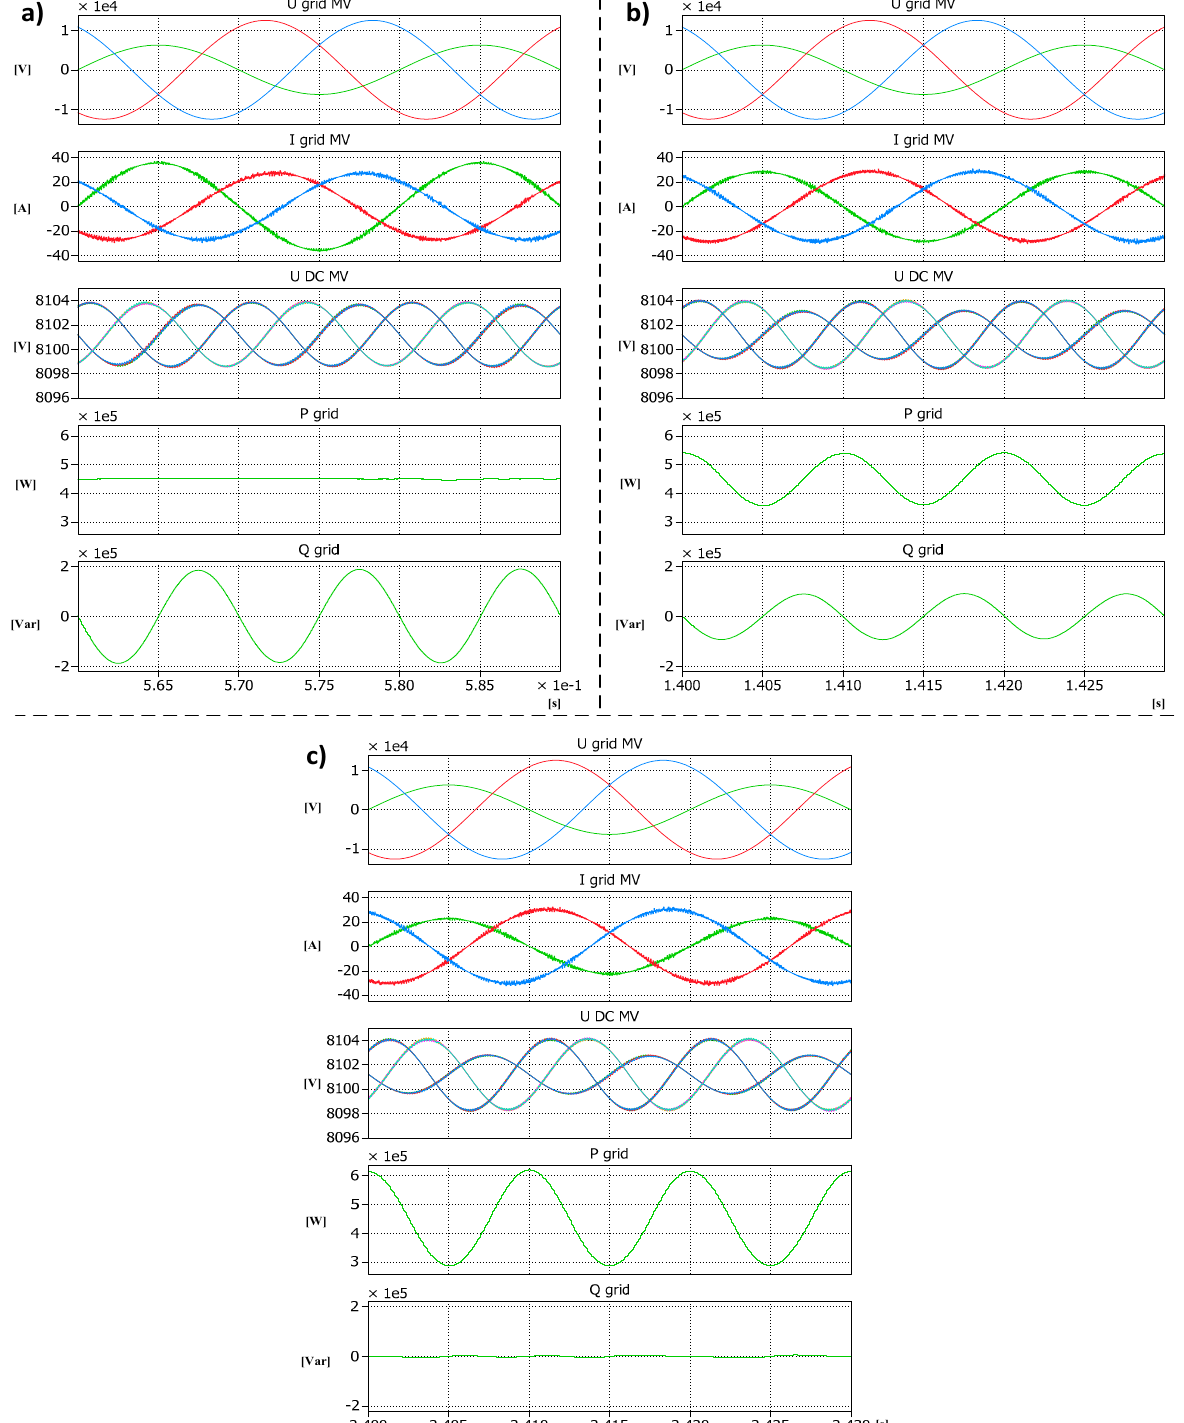
Figure 11. Steady-state operation during 50% phase-to-ground voltage sag: ( a ) constant active power mode of operation, ( b ) symmetrical currents mode of operation, ( c ) faulted phase unloading mode of operation. From the top: grid line voltages u AC , x , grid line currents i AC , x , DC voltages U DC , xk , grid active power P AC , MV , grid reactive power Q AC , MV